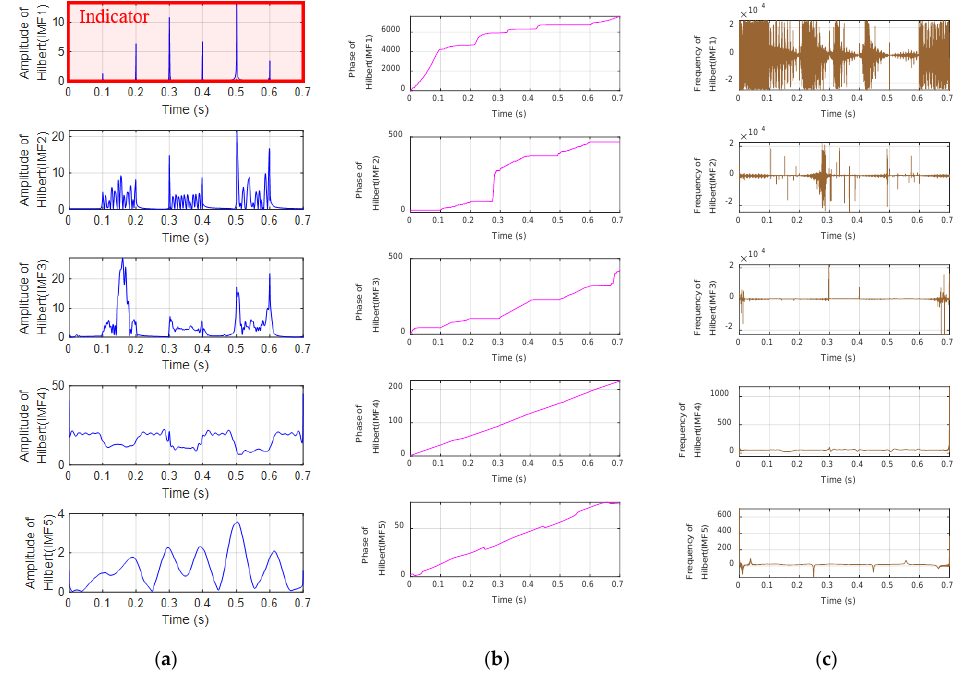
Figure 8. Instantaneous amplitude, phase and frequency of the analytic signals after Hilbert transform applied to the five IMFs. ( a ) Instantaneous amplitude of the five IMFs after Hilbert transform. ( b ) Instantaneous phase of the five IMFs after Hilbert transform. ( c ) Instantaneous frequency of the five IMFs after Hilbert transform.